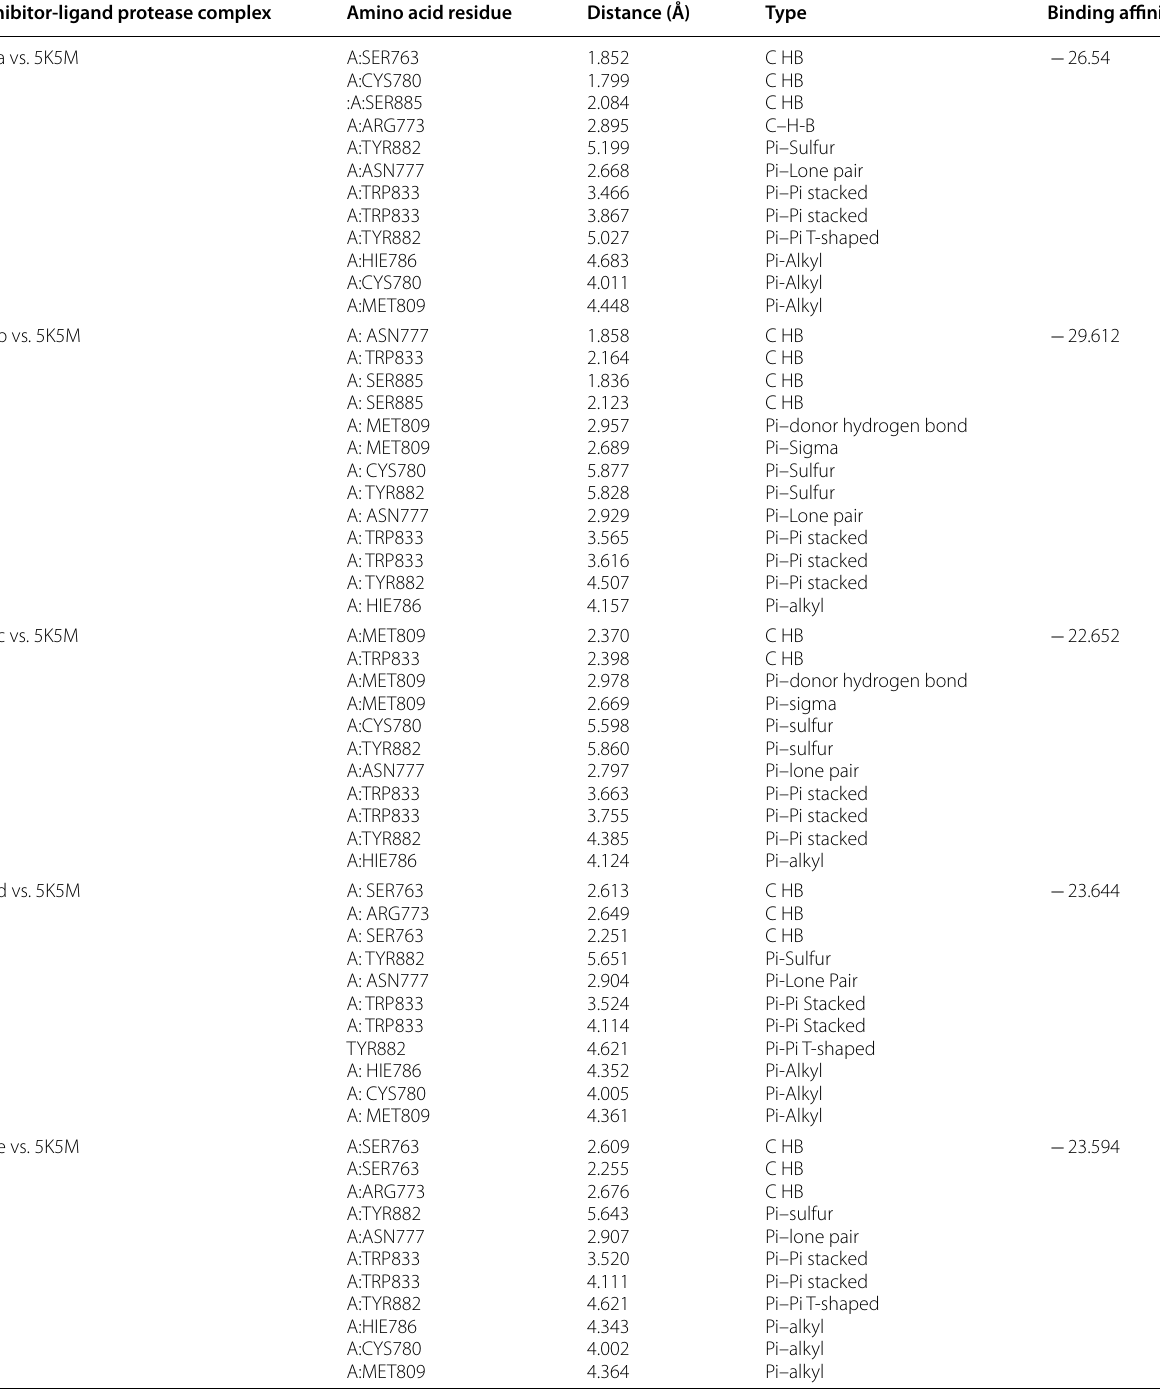
Table 3 Binding interaction distances and amino acid residues types between the designed ligands and the protease Inhibitor‑ligand protease